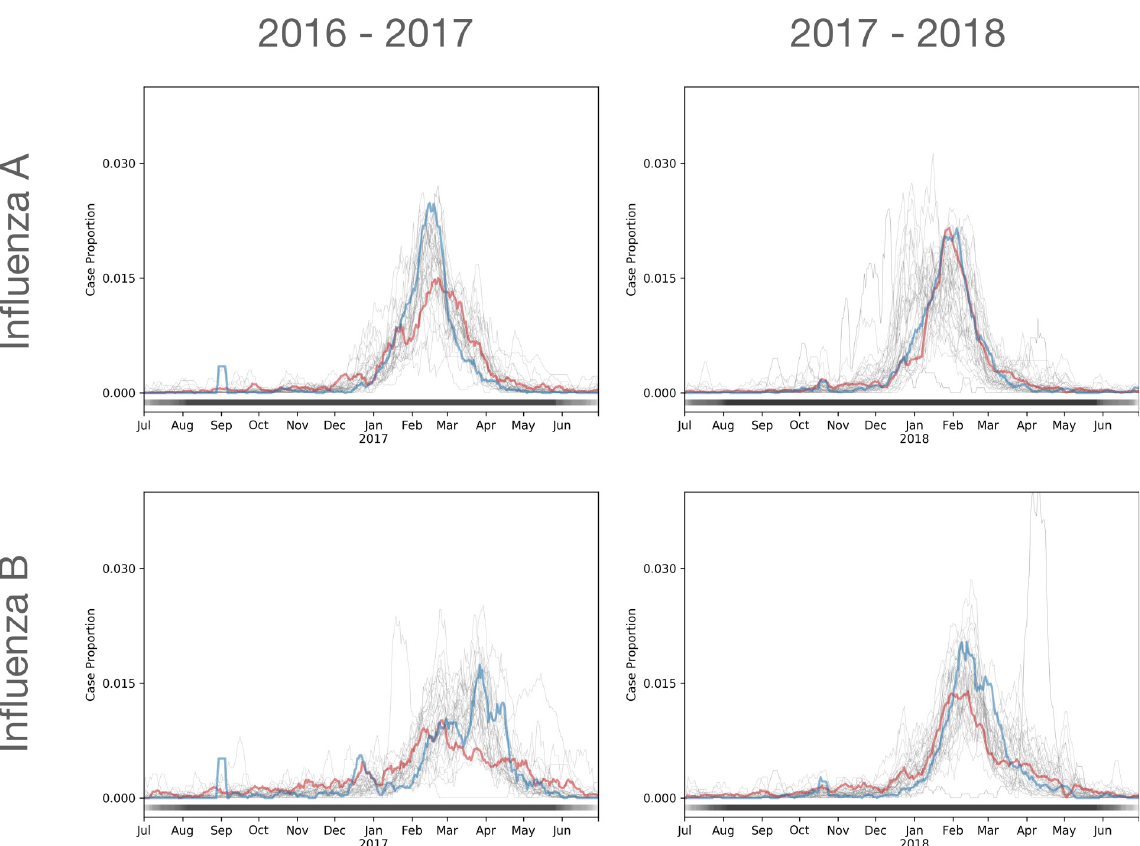
Fig 1. 7-day moving average of positive test results for influenza A and B in each subregion. The y-axis indicates the proportion of annual positive test results. To highlight differences is seasonal characteristics across regions we display Orlando, FL (red) and Des Moines, IA (blue). The thick horizontal line at the bottom of the plot shows the distribution of the beginning/end of the influenza season; black areas are within the influenza season for all locations and lighter shades are a mix between influenza and baseline